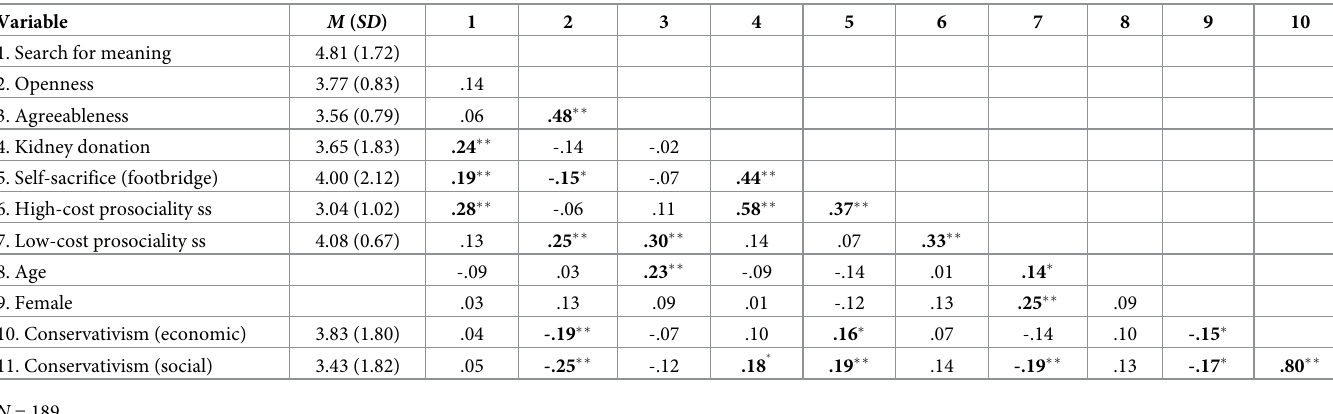
Table 7. Correlations matrix and descriptives in Study